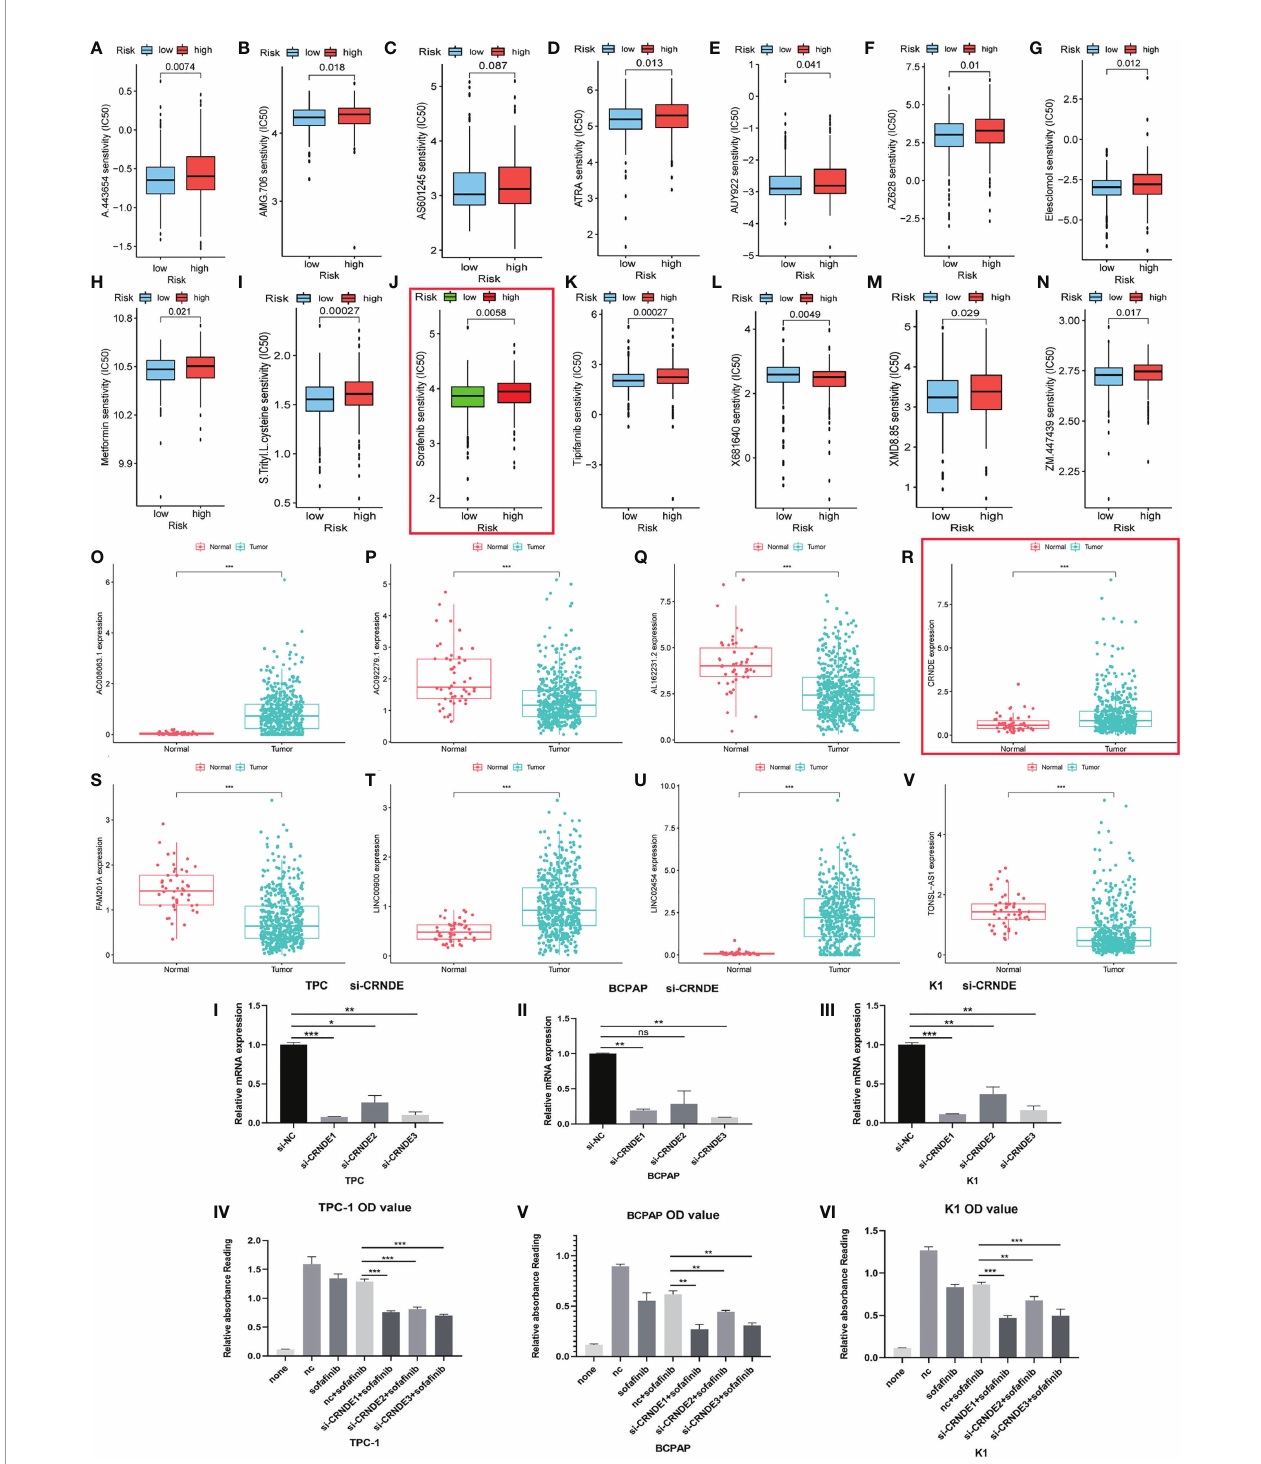
FIGURE 8 | Evaluation and valuation of the prediction ability of sensitivity of risk strati fi cation for common clinical chemotherapies and targeted therapies. (A – N) The risk strati fi cation also can act as a powerful predictor of chemosensitivity for clinical chemotherapeutics. (O – V) The expression of 10 long noncoding RNAs (lncRNAs) in papillary thyroid carcinoma (PTC) and normal tissue. (IV – VI) Here, 2 µM sorafenib was added after knocking down CRNDE in three PTC cell lines. I-III: Ef fi ciency of knocking down were con fi rmed with qRT-PCR. Symbols *, **, *** means that p-value <0.05, <0.01 and <0.001, respectively. The expanded form of ns means that no signi fi